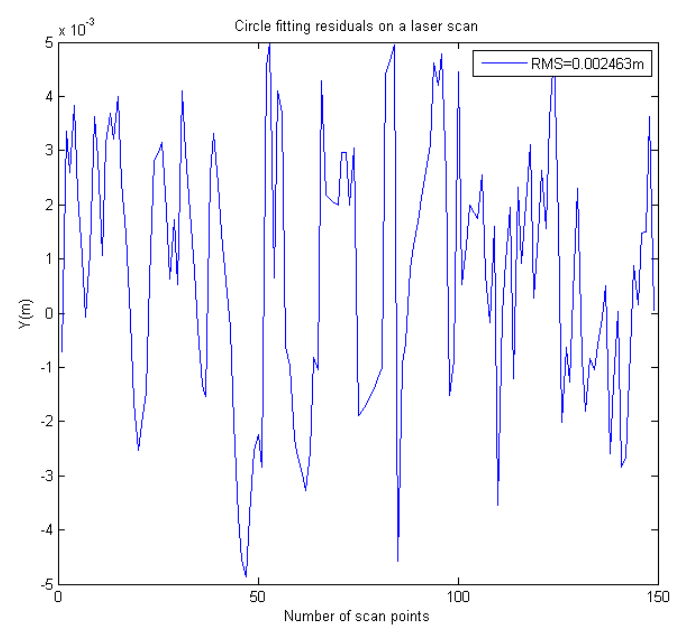
Figure 5. Circle fitting on a laser scan. The number of interior points (blue points) in the circle model (green circle) is 149.